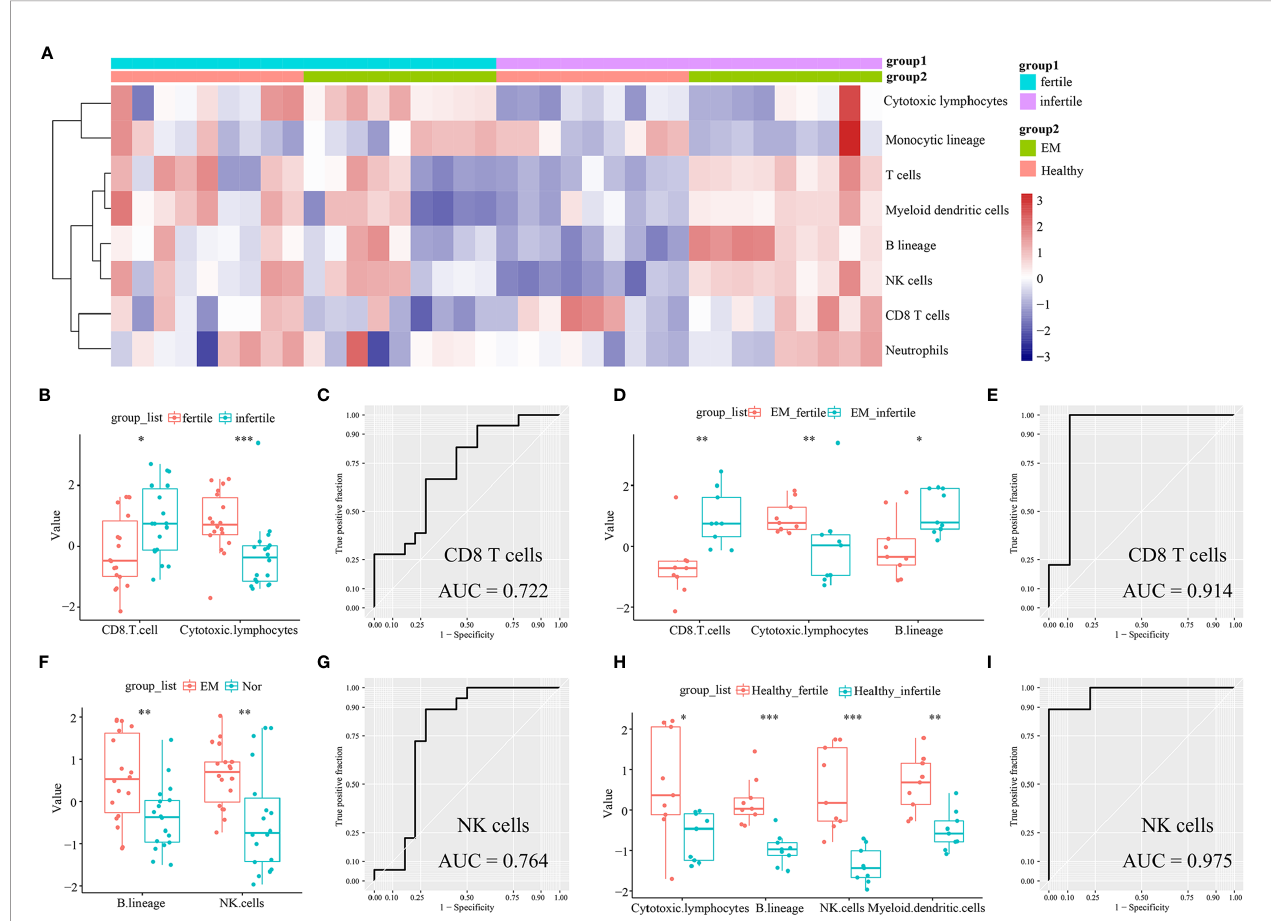
FIGURE 4 | Estimation of in fi ltrating immune cells in the endometria of fertile and infertile cohorts (GSE120103) by the MCP-counter method. (A) The heatmap shows the absolute abundance of eight immune cell subsets. (B) Boxplots show differential in fi ltrating immune cells (CD8 T cells and cytotoxic lymphocytes) between fertile (n = 18) and infertile (n = 18) groups. (C) The ROC curve of CD8+ T cells in fertile and infertile cohorts (n = 36). (D) Boxplots show differential in fi ltrating immune cells (CD8 T cells, cytotoxic lymphocytes, and B lineage) between fertile (n = 9) and infertile (n = 9) groups in patients with endometriosis. (E) The ROC curve of CD8+ T cells in patients with endometriosis (n = 18). (F) Boxplots showing differentially in fi ltrating immune cells (NK cells and B lineage) in women with (n = 18) or without (n = 18) endometriosis. (G) The ROC curve of NK cells in women with or without endometriosis (n = 36). (H) Boxplots show differential immune cells (cytotoxic lymphocytes, B lineage, NK cells, and myeloid dendritic cells) between fertile (n = 9) and infertile (n = 9) groups in healthy women. (I) The ROC curve of NK cells in a cohort of healthy women (n = 18). Data were assessed by the Wilcoxon rank-sum test. *P < 0.05, **P < 0.01, and ***P < 0.001. AUC, the area under the ROC